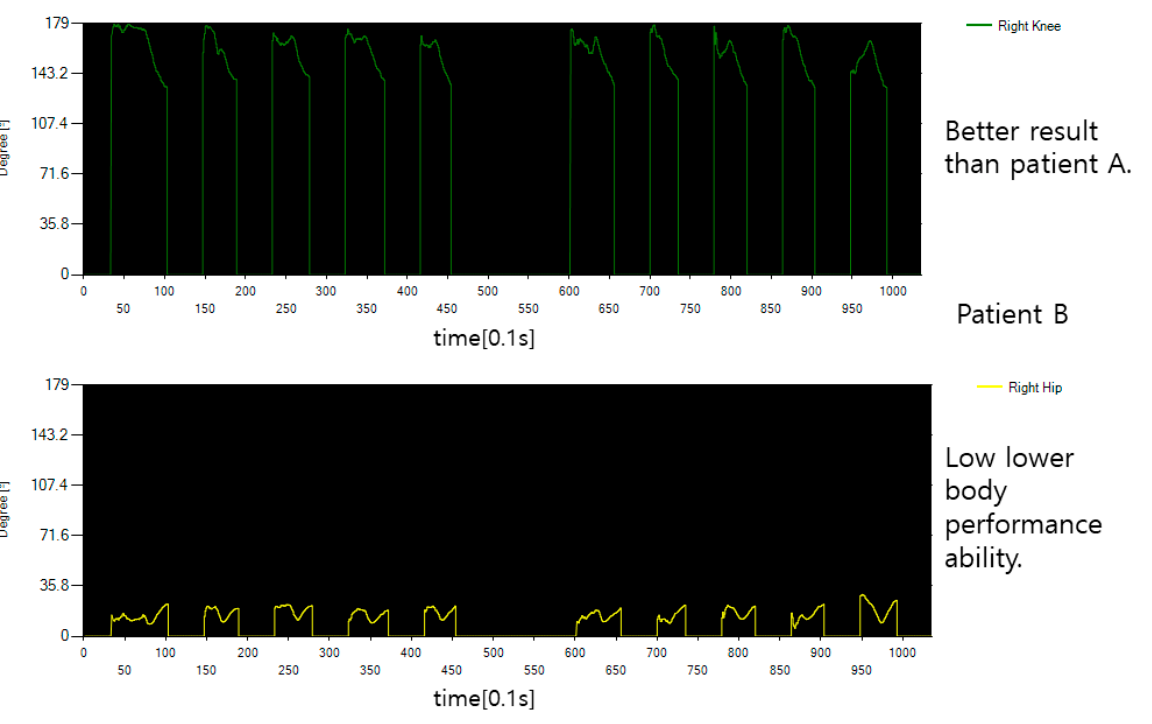
Figure 13. The angle data of patient A sitting motion.